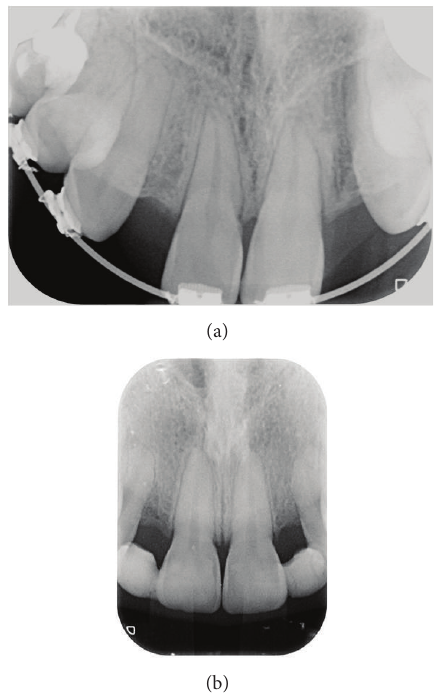
Figure 2: Radiographic preoperative condition.